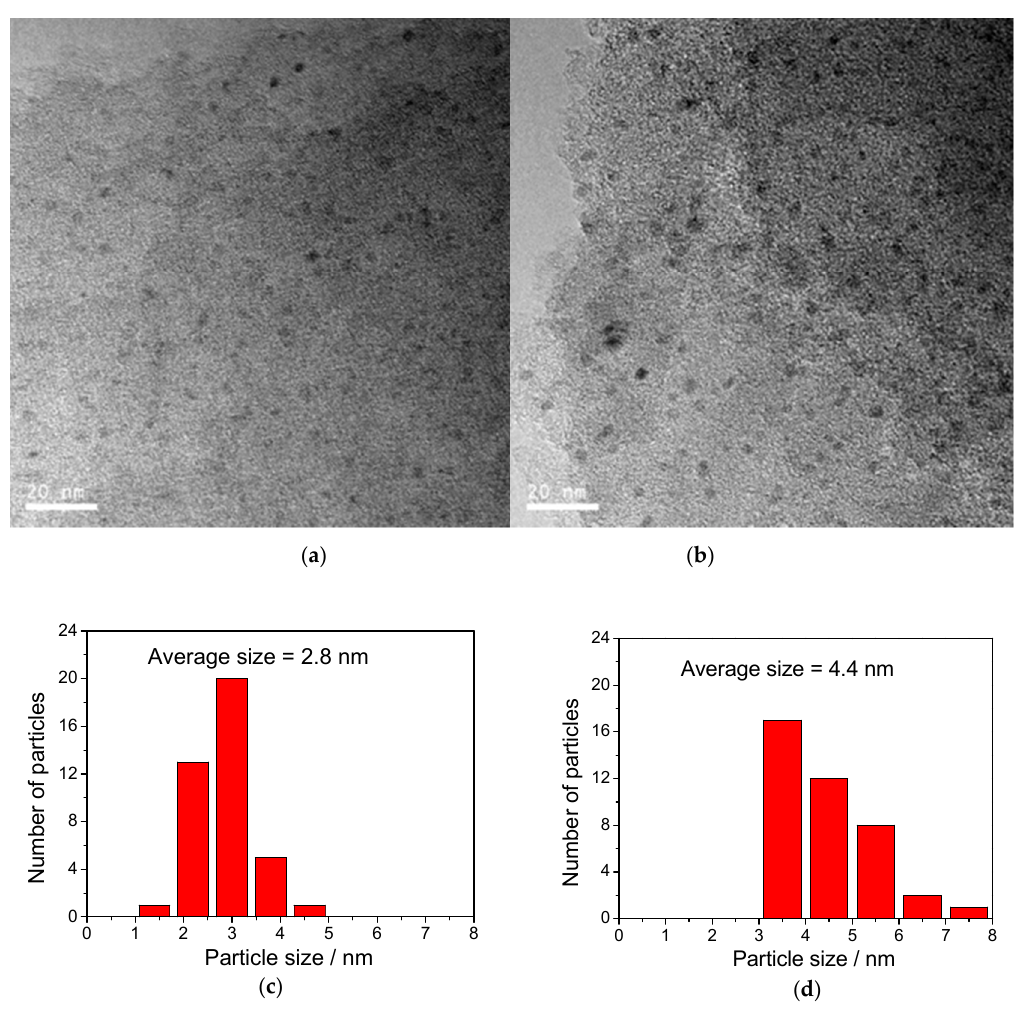
Figure 7. TEM images of ( a ) spent Pd/AC and ( b ) spent Pd/N-AC, and Pd size distribution of ( c ) spent Pd/AC and ( d ) spent Pd/N-AC in the hydrodechlorination of 2,4-DCP.